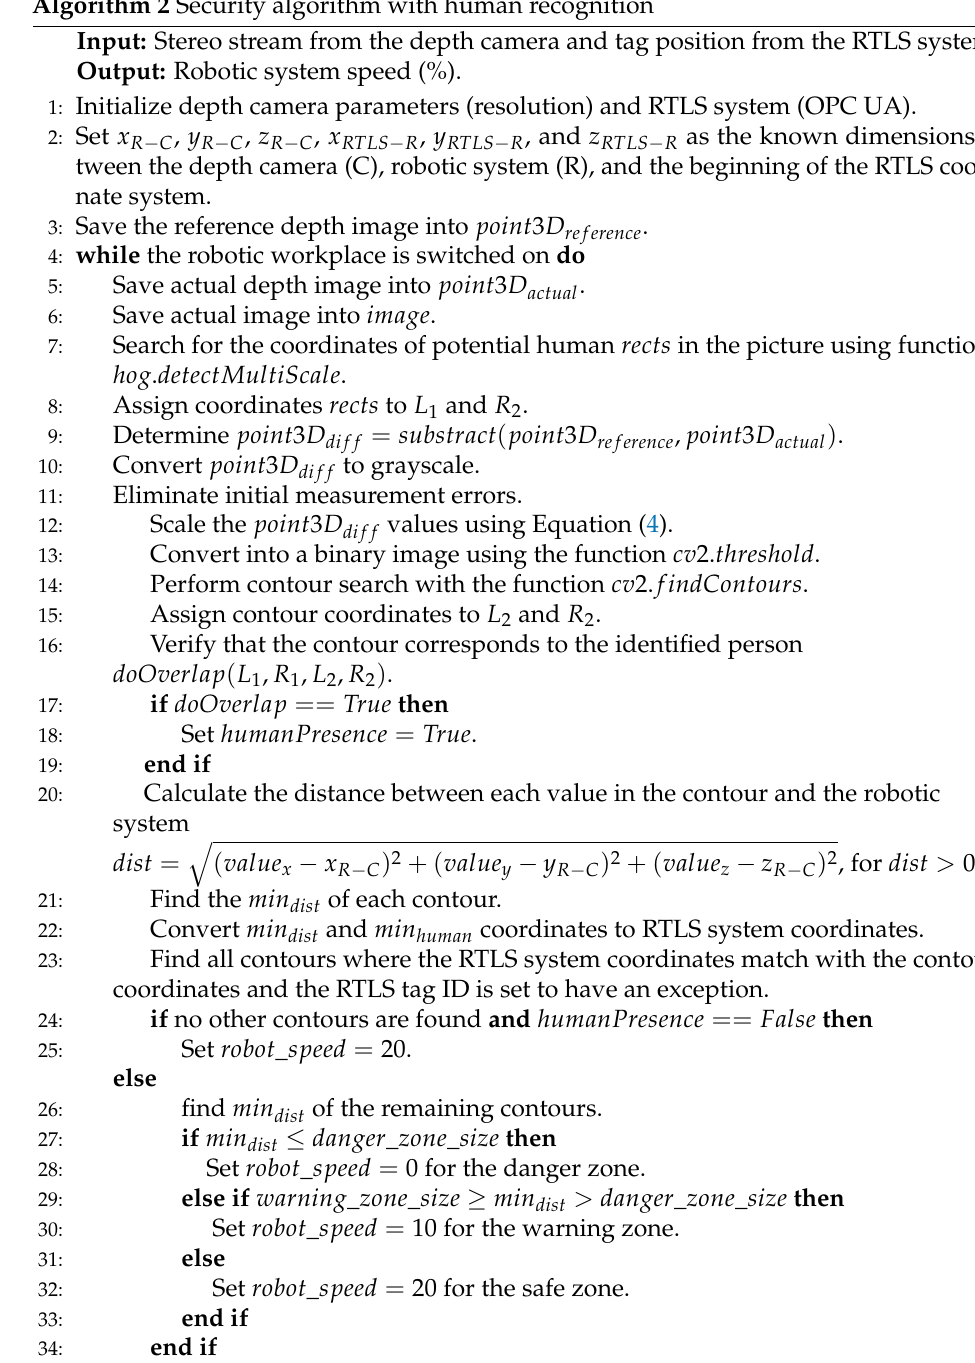
Algorithm 2 Security algorithm with human